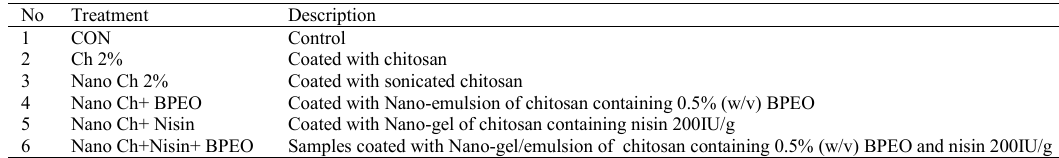
Fig. 1: Image of emulsion and nano-emulsion Table 1. List of treatments in the present study